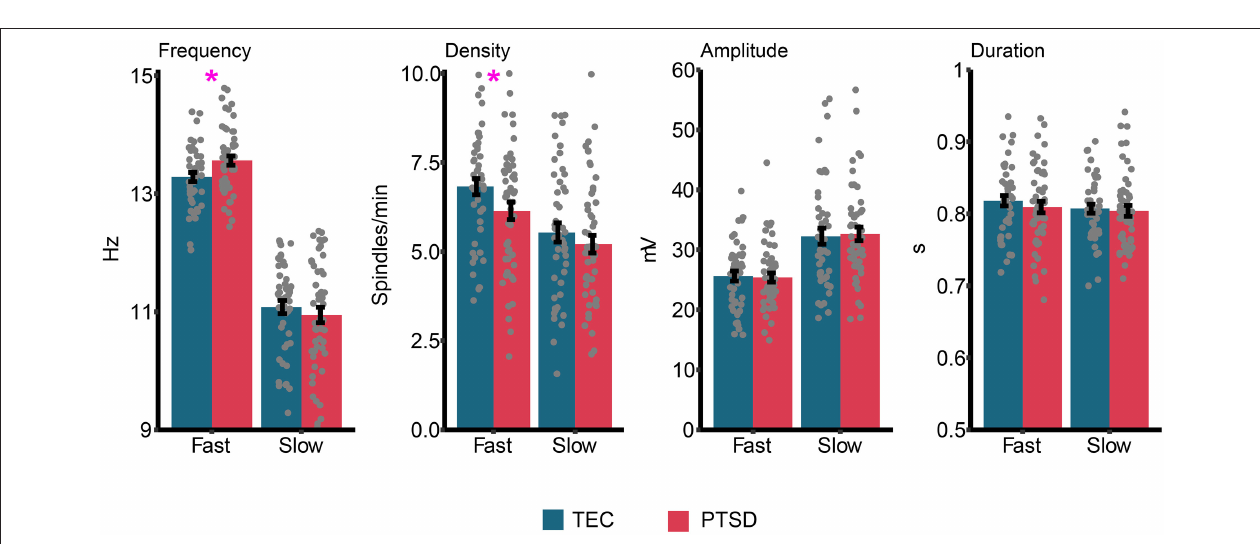
FIGURE 5 | Group differences in sleep spindle properties. Gray dots represent individual data points, and error bars indicate the standard error. * p < 0.05.